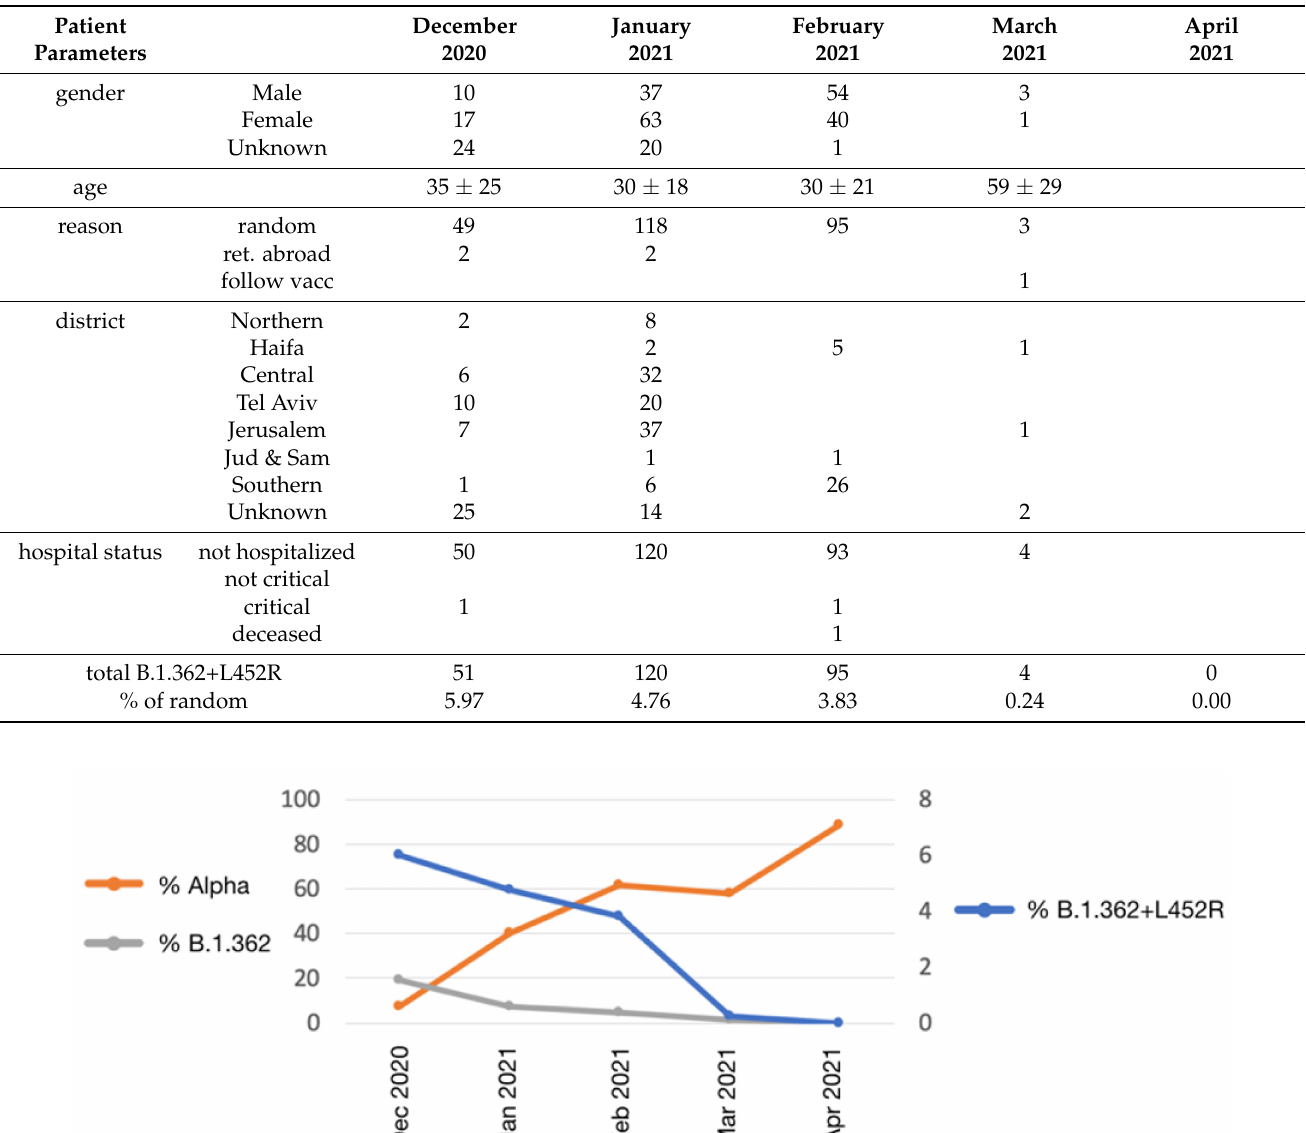
Table 1. Epidemiology of the B.1.362+L452R variant. Frequency and patient-related information of the B.1.362+L452R variant. Ret. abroad is return from abroad; follow vacc is following vaccination; Jud & Sam is Judea and Samaria; hospital stat is hospital status.